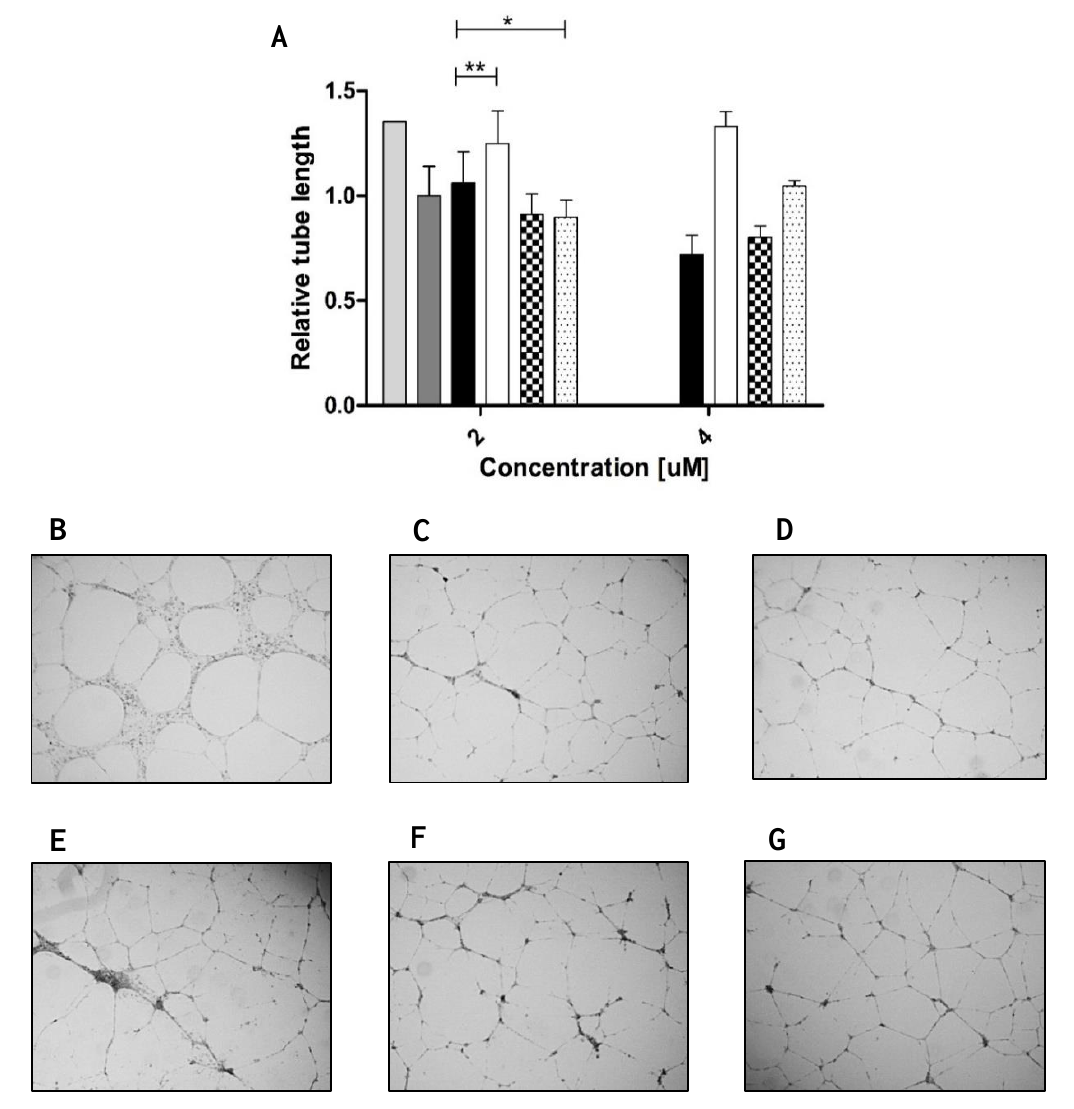
Figure 6. SCF variants with different functional effects on primary human umbilical vein endothelial cells (HUVECs). ( A ) HUVECs with 2% fetal bovine serum (FBS) as the positive control (light gray column), untreated HUVECs as negative control (dark gray column), and cells treated with 4 µM of SCF WT (black columns), SCF M (white columns), SCF M,K91E (checkered columns) and SCF M,K91E,L98R (dotted columns). Tube length was normalized to untreated cells, which served as a control. Values are means ± SEM of independent measurements performed in triplicate. ( B ) Positive control. ( C ) Negative control. ( D ) SCF WT. ( E ) SCF M . ( F ) SCF M,K91E . ( G ) SCF M,K91E,L98R . In panels ( B – G ) all proteins were added at a concentration of 4 µM. * p < 0.05; ** p < 0.01.